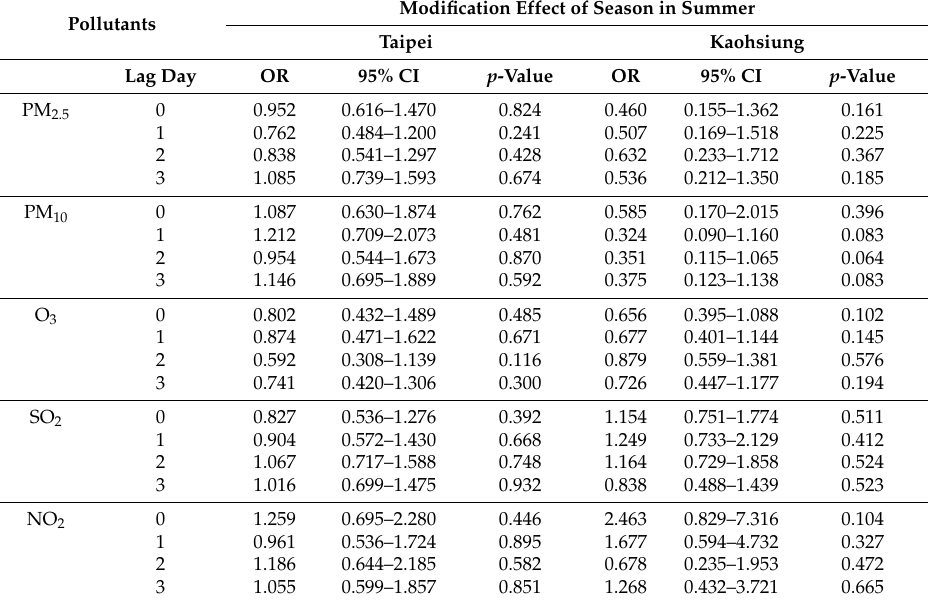
Table 5. Association between air pollution and childhood asthma in summer.